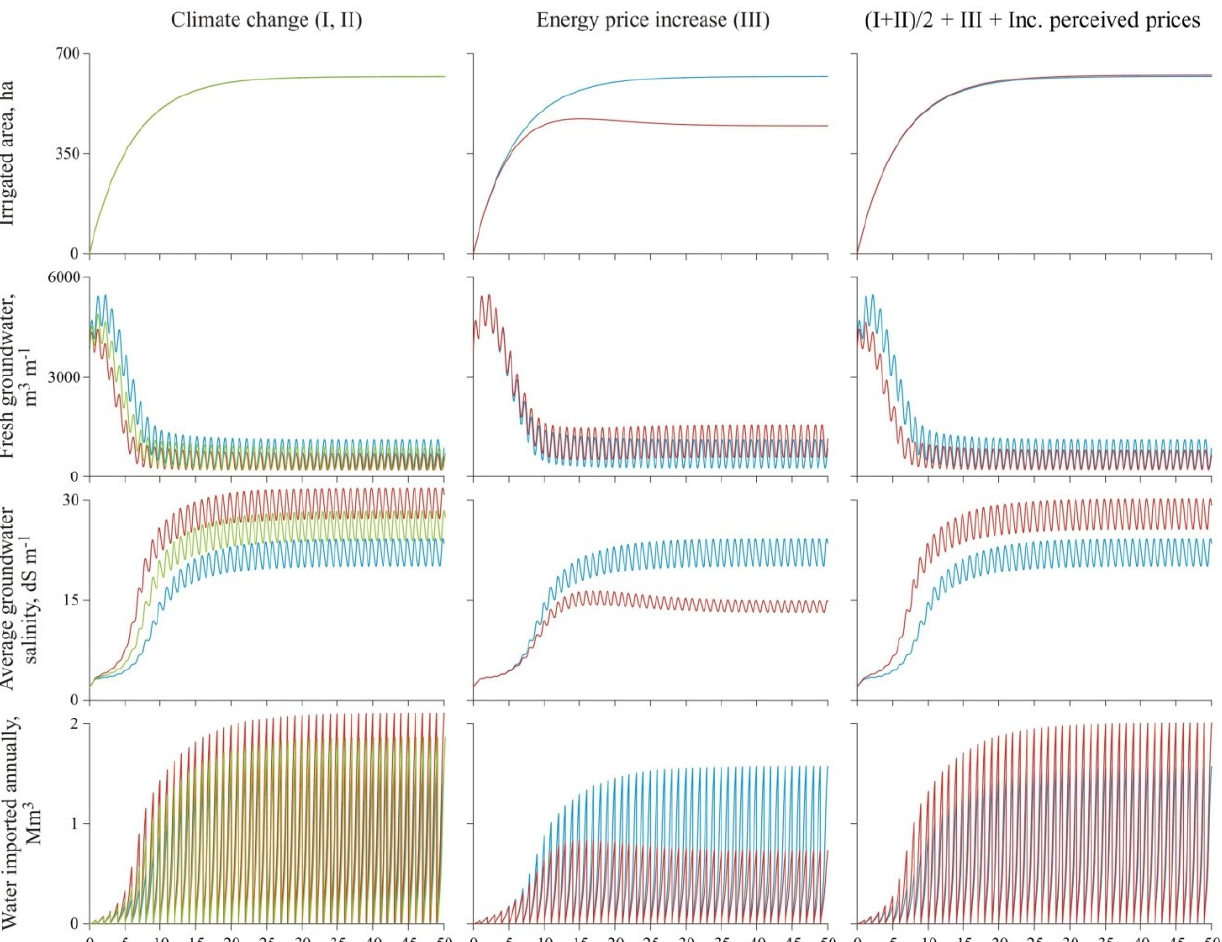
Figure 4. Comparison of the default scenario (blue line) with alternative scenarios (green and red lines). The scenarios are specified in Supplementary Table S3. In Scenario I, a 14.4% drop in “average rainfall recharge” is simulated (green line in the left column charts). In Scenario II, this drop is 26.6% (red line in the left column charts). Scenario III includes an 85% increase in “energy price”, and a 35% in “price of one cubic meter of external water” and “other costs per hectare” (red line in the middle column charts). Finally, Scenario IV includes a 20.5% reduction in the parameter “average rainfall recharge”, the same increases in costs as Scenario III and a 35% increase in the parameter “revenue per hectare” (red line in the right column charts).